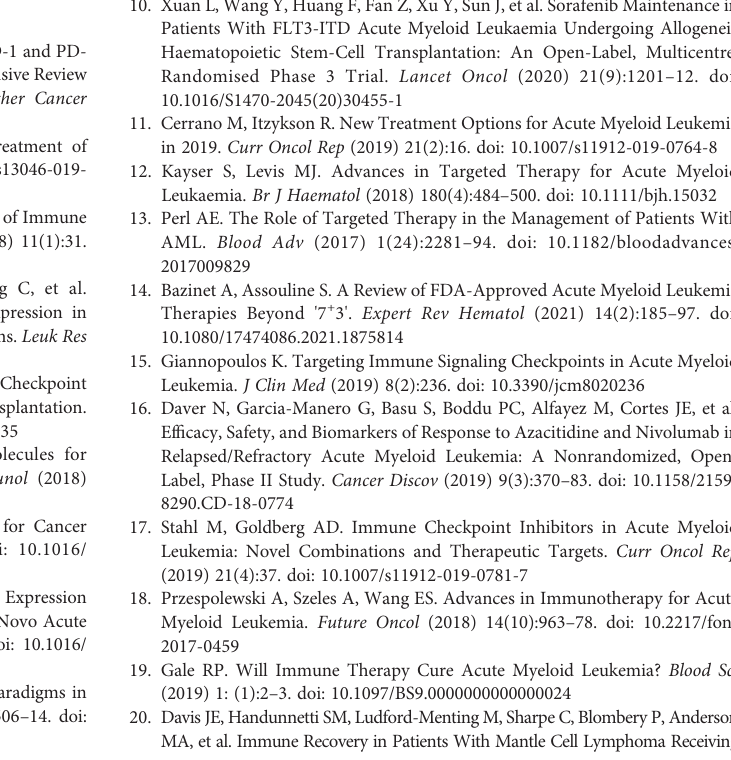
Supplementary Figure 1 | Expression frequency of TIGIT on the PB CD4 + and CD8 + subsets of the HI, DN-AML, and CR-AML cohorts in the young and old age groups. Flow-cytometry analysis shows that the expression frequency of TIGIT increased in the PB CD4 + population of DNy patients when compared with HIy. Supplementary Figure 2 | The absolute number of CD3 + , CD4 + , and CD8 + T cells in the PB and BM of the HI and AML cohorts. The total CD3 + T cell number in PB heavily decreased in CR and R/R patients who received induction chemotherapy, and total CD3 + T cells in the BM increased in DN-AML patients when compared with